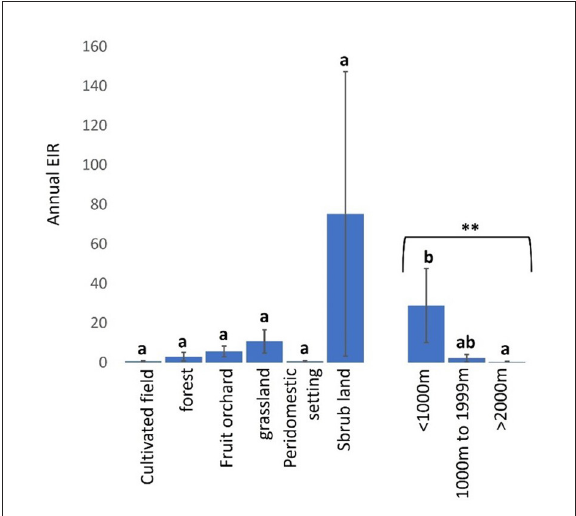
FIGURE7 Annual EIR of tsetse flies according to vegetation landscape and proximity to wildlife reserve in Shimba Hills. Error bars are used to indicate the standard error of the mean (SEM). Letters have been used to indicate presence or absence of significant difference in pairwise comparisons of tsetse fly entomological inoculation rates. Pairwise comparisons are made between tsetse flies within the same group defined by vegetation site or distance from the wildlife reserve. Significantly different pairs are denoted using different letters while insignificantly different pairs are indicated using same letters. **Indicates P value <